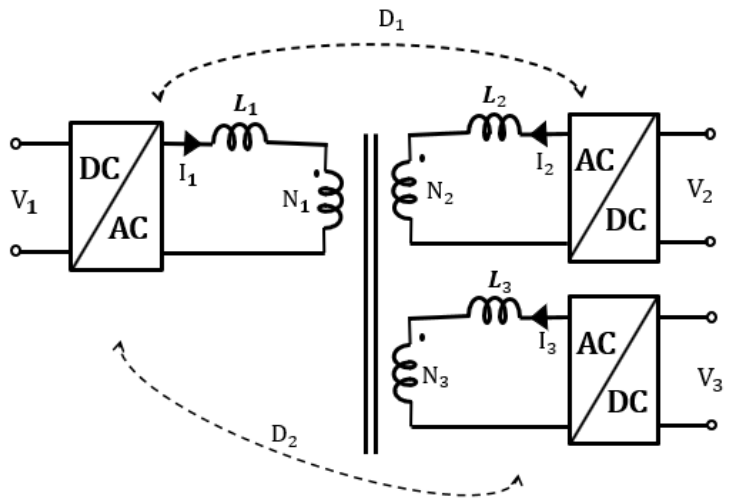
Figure 1. Block diagram representation of the three-winding transformer-based DC–DC converter.